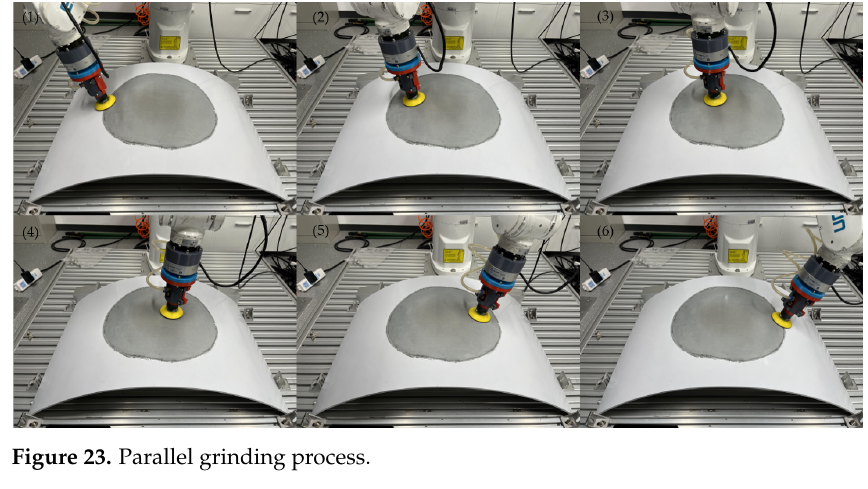
Figure 23. Parallel grinding process.